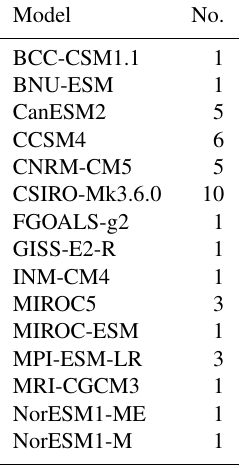
Table 2. List of CMIP5 models (with number of realizations) used for sea ice analysis of both historical and future